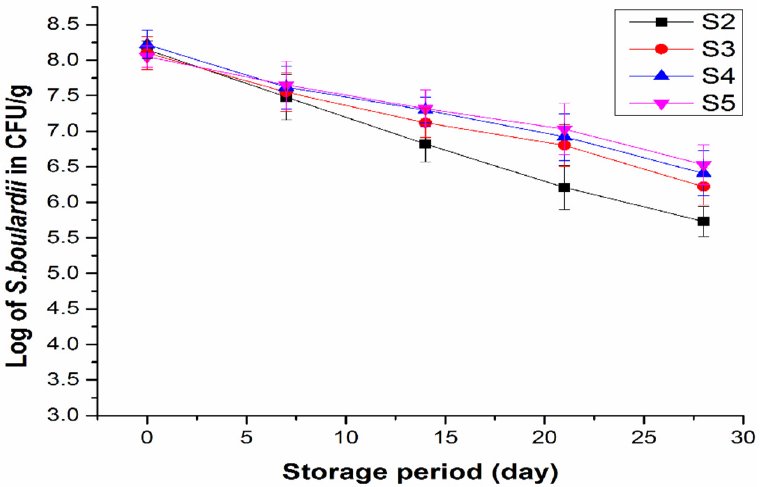
Figure 3. Survival of S. boulardii in the yogurt samples during storage at 4 ◦ C for 28 days: Probiotic yogurt with 0.5% S. boulardii (S2), synbiotic yogurt with 0.5% S. boulardii + 1% inulin (S3), 0.5% S. boulardii + 1.5% inulin (S4), 0.5% S. boulardii + 2% inulin (S5).